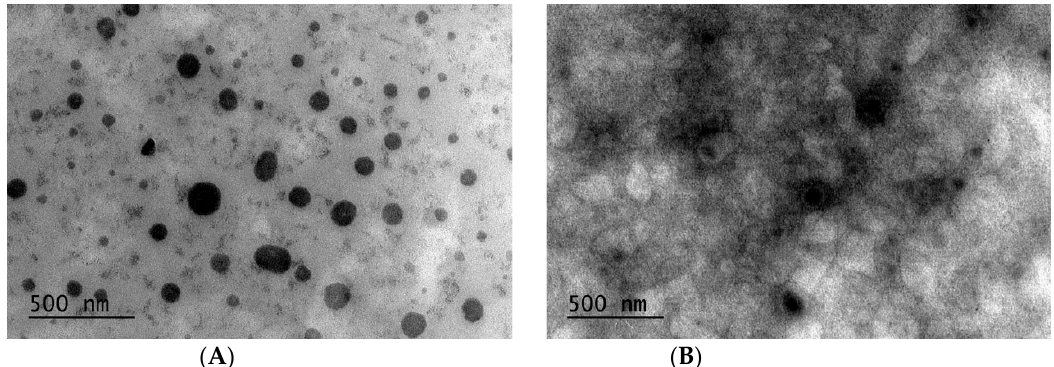
Figure 2. Transmission electron micrographs of ( A ) Blank and ( B ) RFB-loaded NLC.